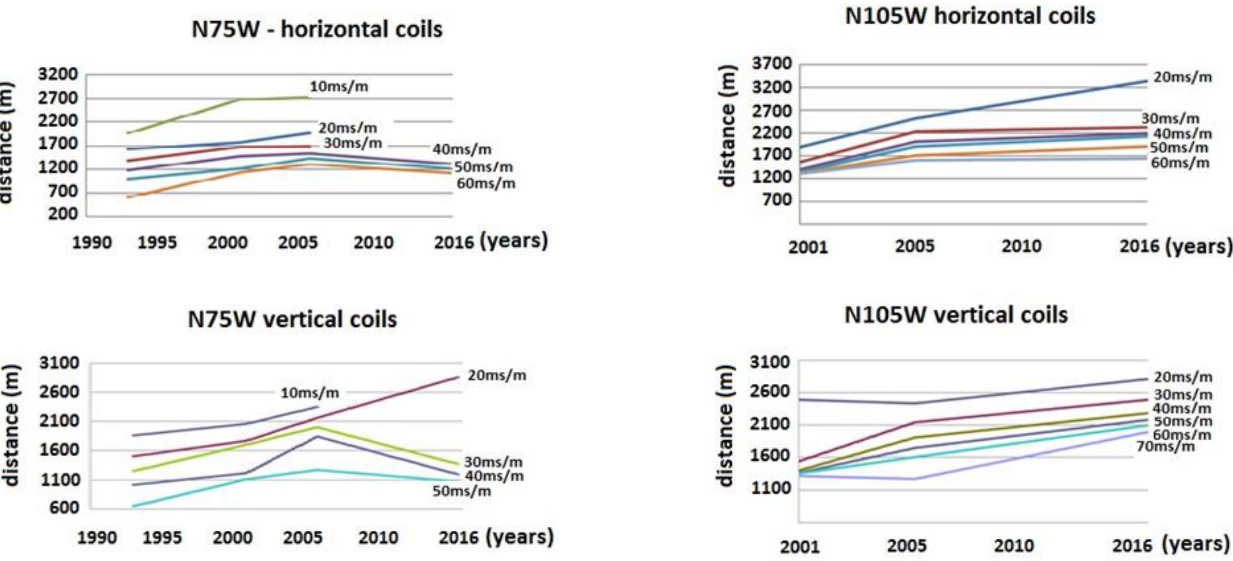
Figure 6. Electrical conductivity variation along profiles N75° W and N105° W over time.